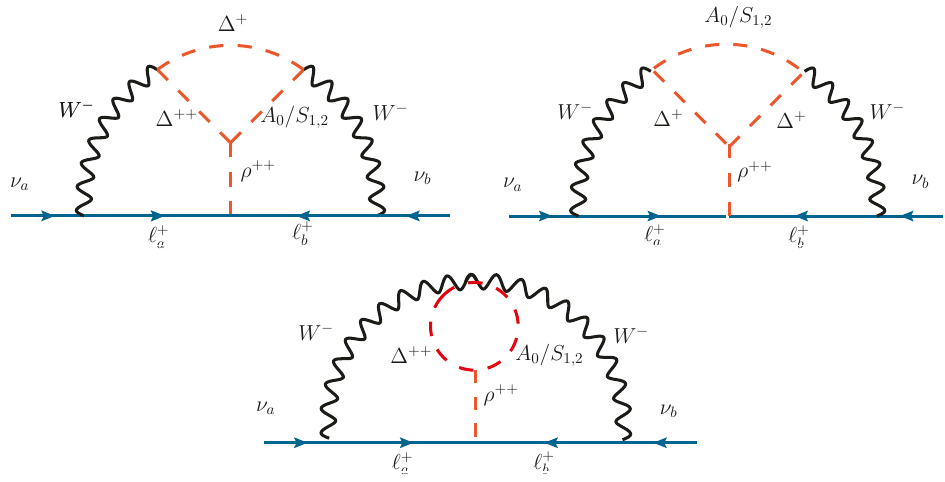
Figure 6 . Example Feynman diagrams yielding neutrino masses in the Inert Triplet Dark Matter Model. BSM propagators are depicted in